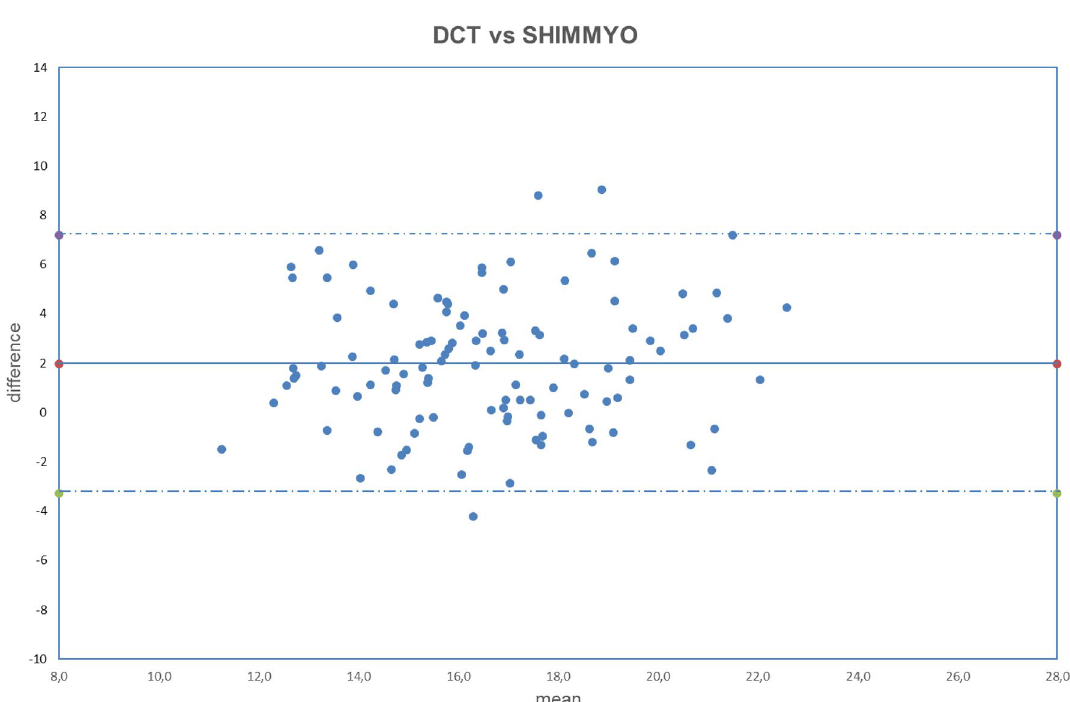
Figure 2. Bland–Altman plot between IOP measured with DCT and GAT corrected with Shimmyo formula. Dashed line: mean difference. Dash-dotted lines: mean difference (1.97 mmHg) ± 2 standard deviation (2.62 mmHg) of the